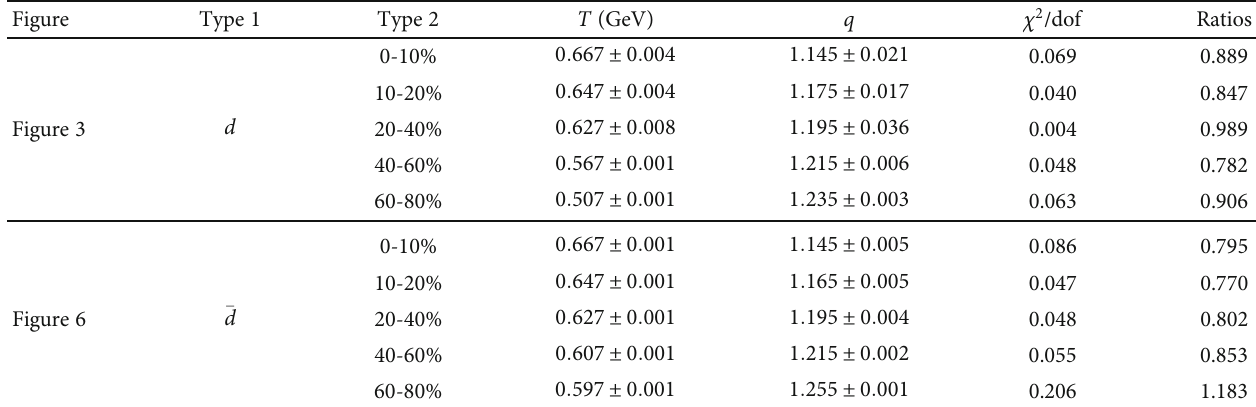
Table 4: Values of T , q , and χ 2 /dof corresponding to the curves in Au+Au collisions at 60%, and 60-80% centralities. The “ Ratios ” is the average ratios of experimental data to